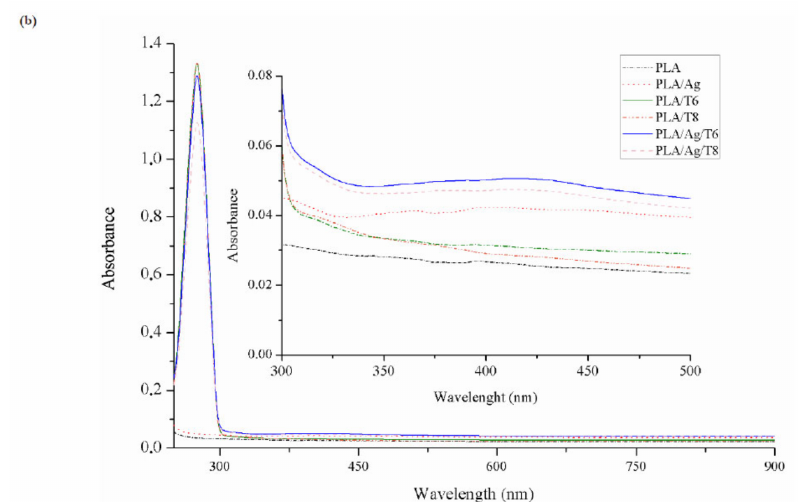
Figure 1. Fourier transform infrared spectroscopy (FTIR) ( a ) and ultraviolet–visible (UV-VI)S ( b ) spectra of neat poly(lactic acid) (PLA) and active PLA-based nanocomposite films.